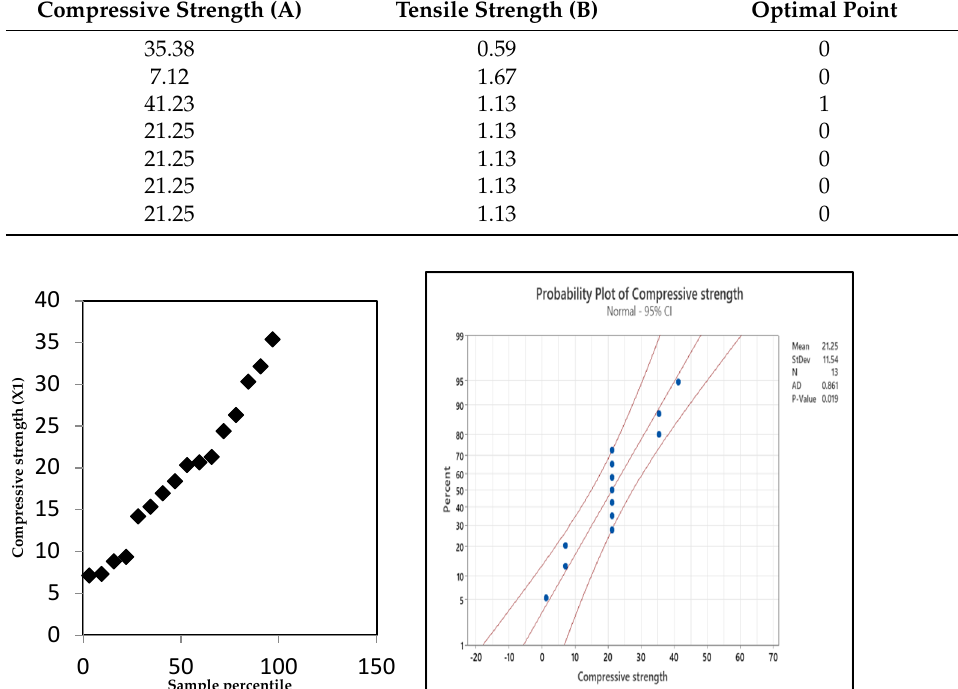
Figure 9. Probability and predicted output of compressive strength.